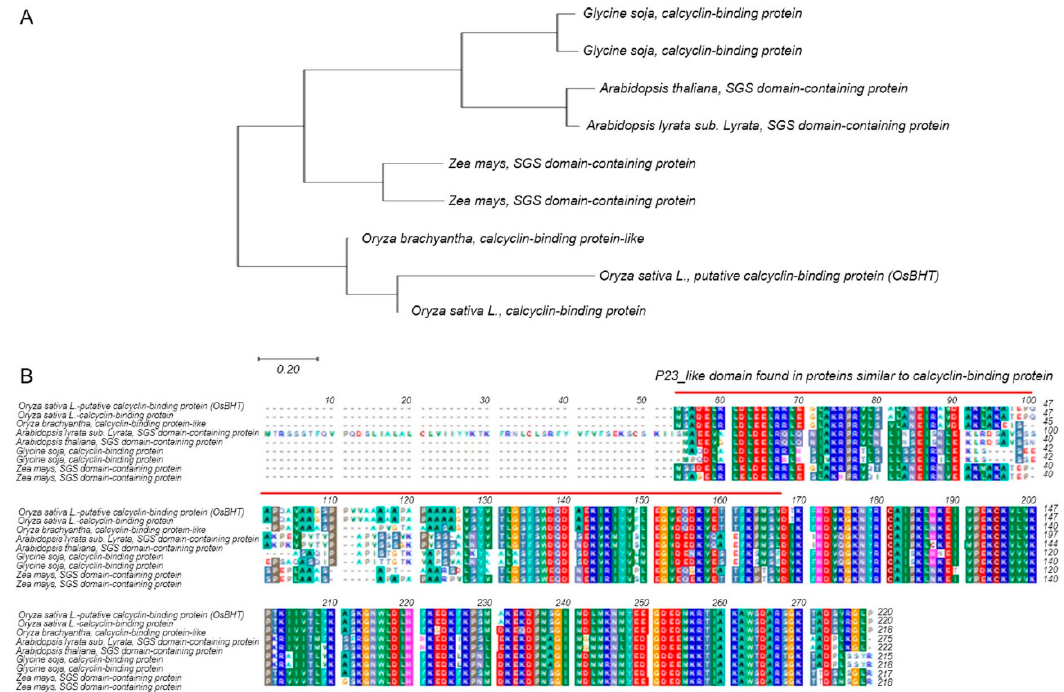
Figure 5. Sequence analysis of Oryza sativa Booting stage Heat Tolerance ( OsBHT ). ( A ) Analysis of the relationship between the OsBHT gene and homology gene by phylogenetic tree. The phylogenetic tree was constructed by the parsimony method with 1,000 bootstrap replicates. ( B ) As a result of comparing the protein sequences of the homologous genes of OsBHT , a very high similarity was shown in Oryza sativa , Arabidopsis thaliana , Zea mays , and Glycine soja.